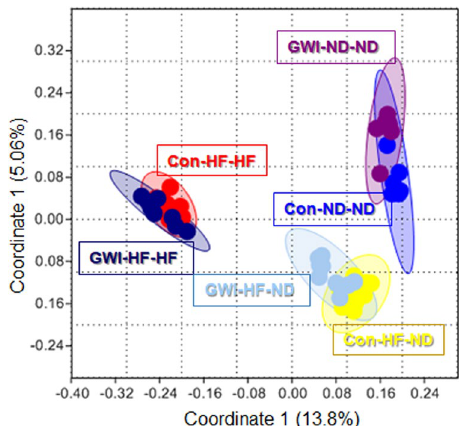
Figure 4. Effects of treatments on β -diversity. PCoA showing differences in the similarities of the gut microbiome profiles of the study groups using the Jaccard index. Con = control; GWI = PER + PB; ND = normal diet; HF = high fat